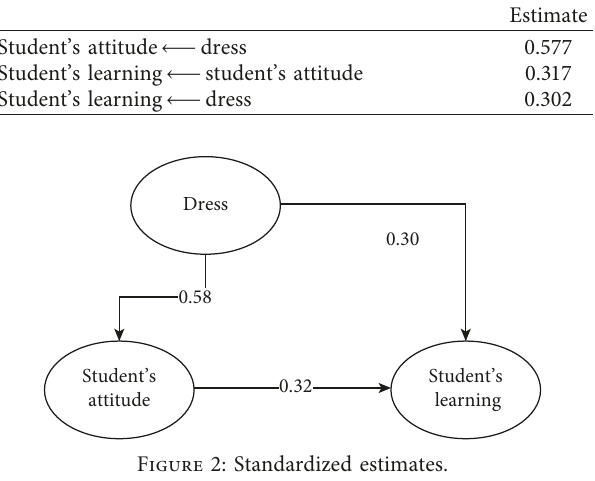
Table 4: Standardized regression weights.